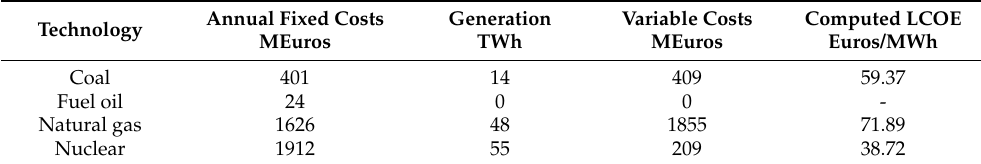
Table 5. Annual expected fixed and variable costs of the thermal technologies in 2030.